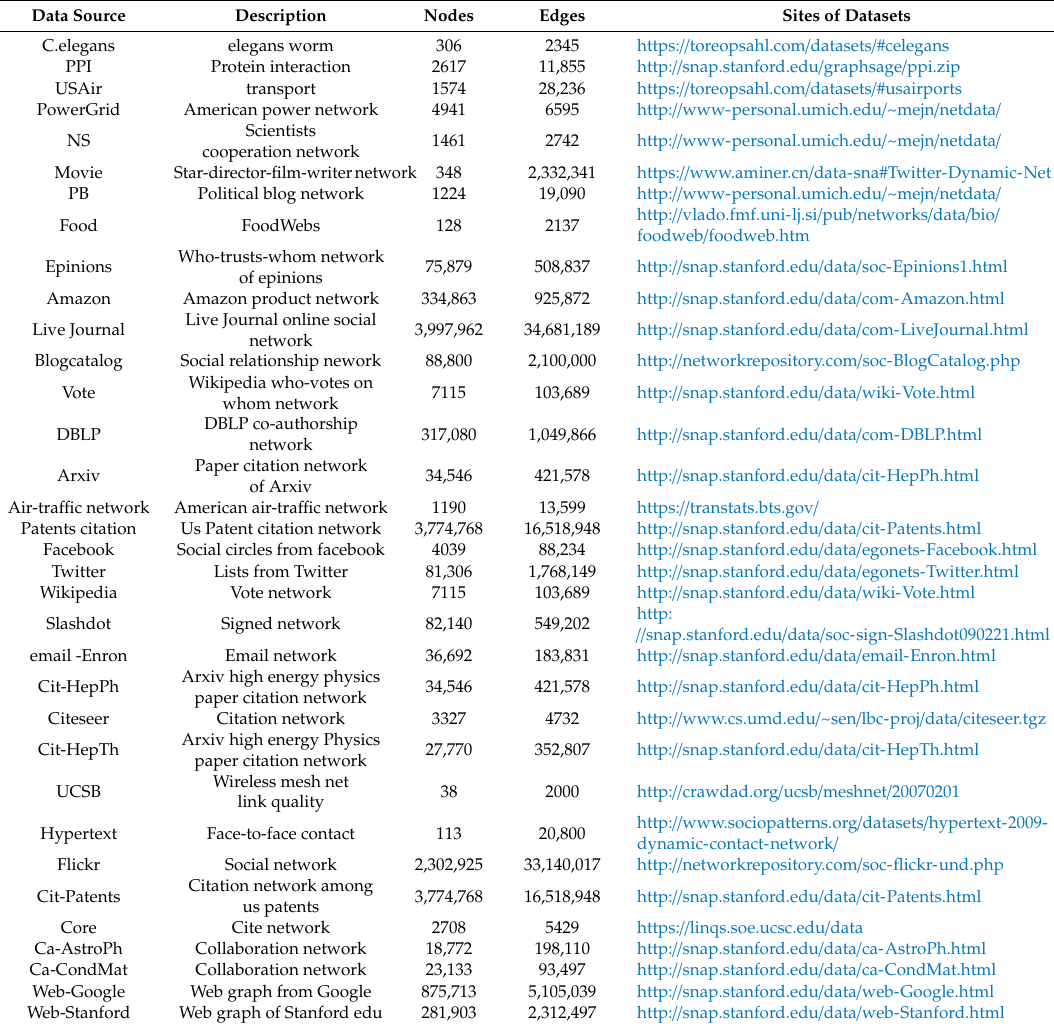
Table 5. Popular open datasets used in link